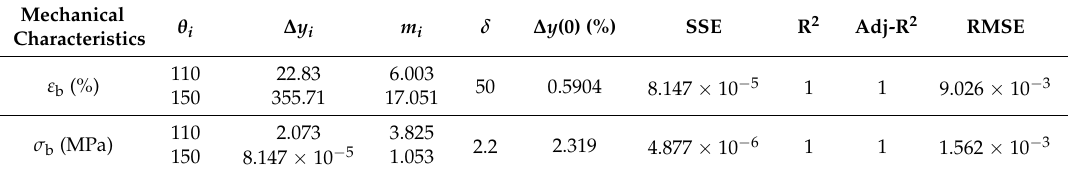
Table 2. Results of the regression analysis of the functional dependence of ε b and σ b of the irradiated material on the magnitude of the radiation dose and statistical analysis of the quality of the found regression model.